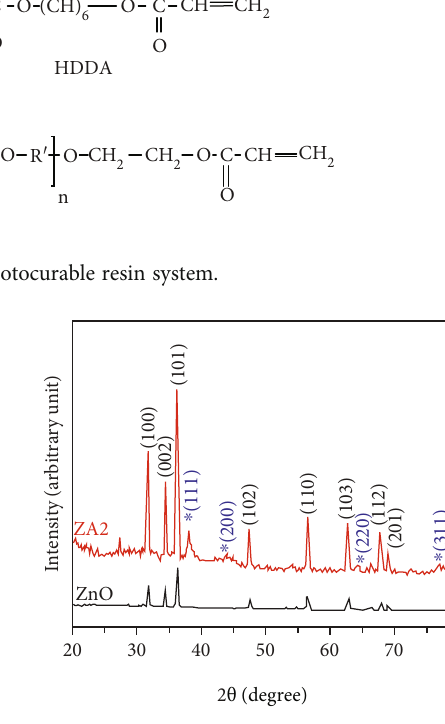
Figure 3: XRD di ff raction diagrams of pure ZnO nanoparticles (ZnO) and ZnO-Ag nanohybrids